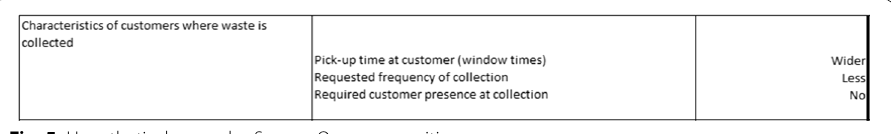
Fig. 5 Hypothetical example. Source: Own